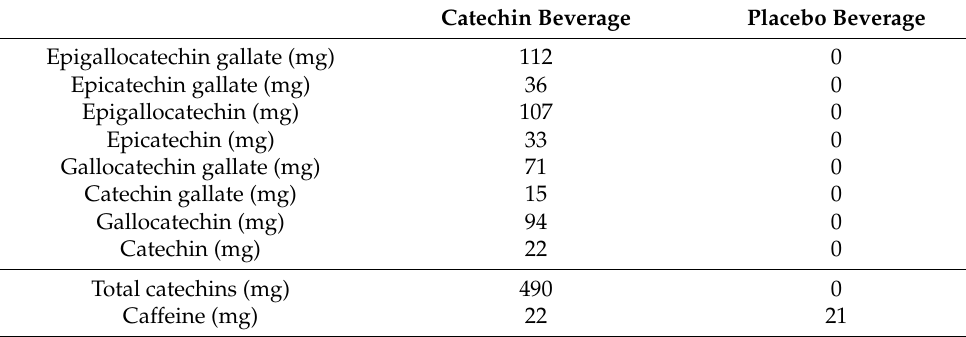
Table 1. Composition of the test